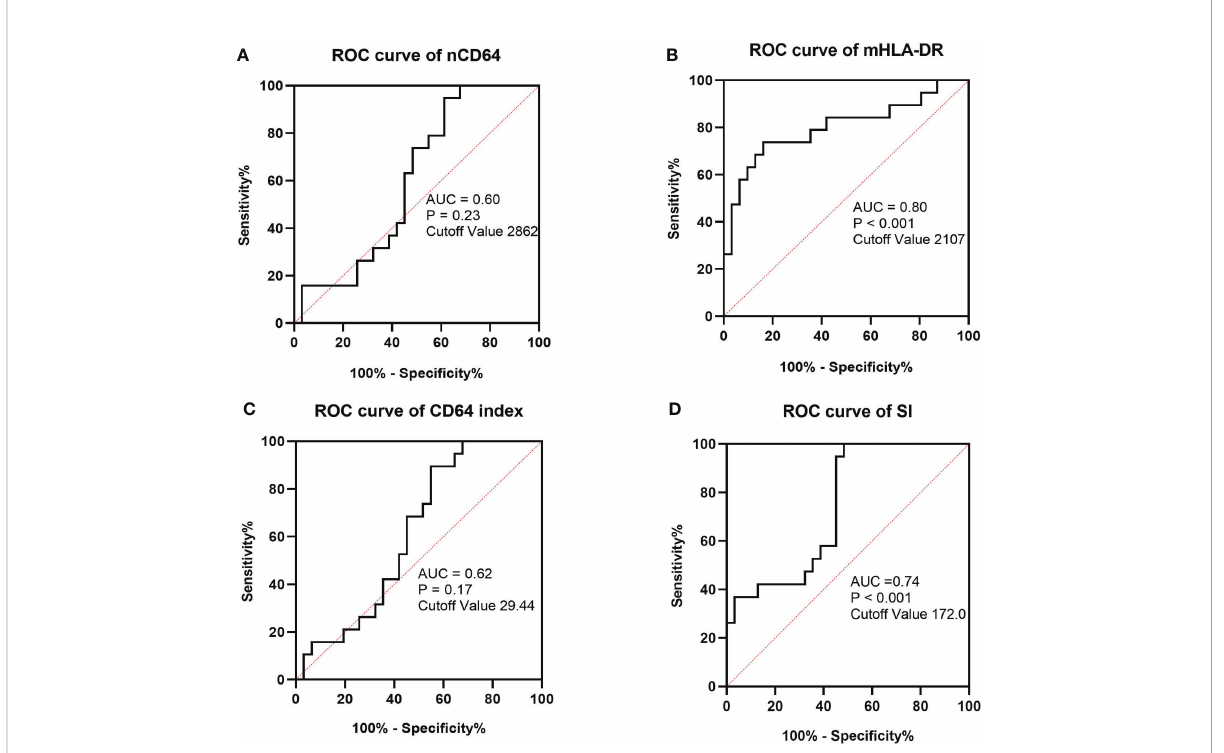
FIGURE 8 ROC curves of MESF of nCD64 (A) , MESF of mHLA-DR (B) , SI (C) and CD64 index (D) for diagnosis of sepsis in KTRs with infection. The cut-off values were determined by the Youden index. ROC, Receiver operating characteristics; AUC, area under the curve; nCD64, neutrophil CD64;